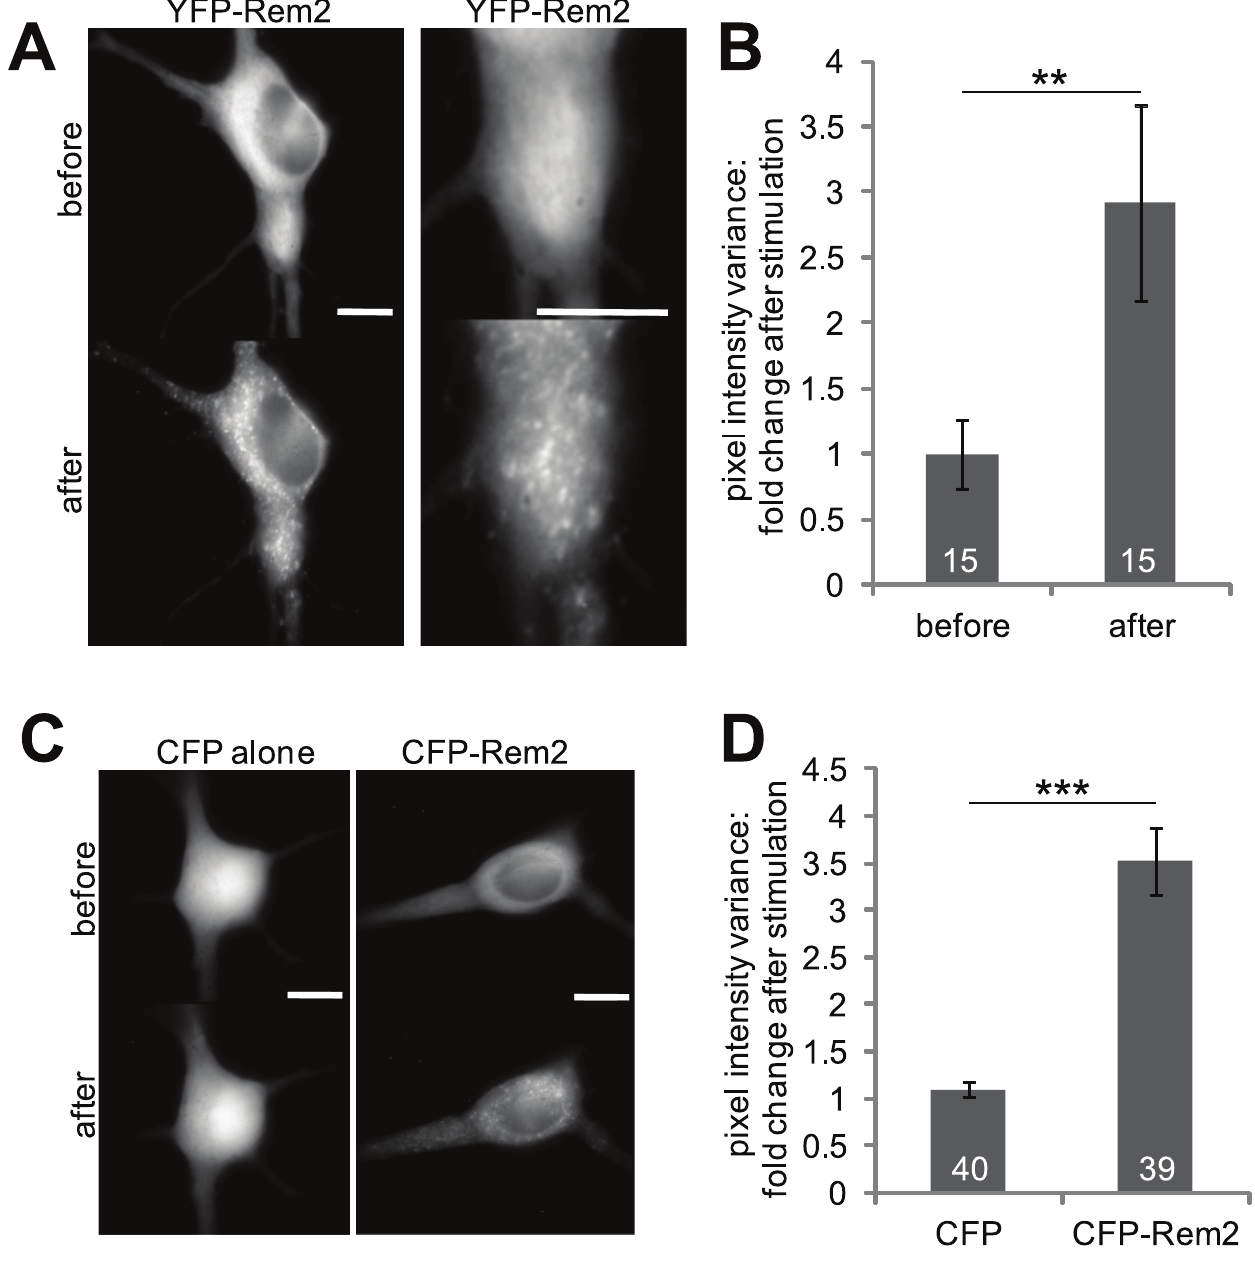
Figure 1. Rem2 overexpressed in neurons redistributes in response to neuronal stimulation. ( A ) Images of neurons expressing either YFP or YFP-Rem2, before and after photoconductive stimulation, a non-invasive method of stimulating individual cells in a culture using light to target neurons grown on a silicon chip. To stimulate specific cells, we targeted the cell bodies of transfected neurons using a YFP filter, then stimulated the chip using 3–5 V of current for 2 msec duration at 20 Hz for 5 sec. Cells were imaged before and after stimulation to compare Rem2 distribution. Right panel is a magnification of the left panel to show details of Rem2 puncta. Scale bars represent 10 m m. ( B ) Normalized pixel value variance before stimulation, 1.0 6 0.26; after stimulation, 2.92 6 0.75, N=15; paired t-test p=0.006. Error bars represent SEM, and numbers within the bars indicate the number of cells averaged. ( C ) Images of neurons expressing either CFP or CFP-Rem2, before and after chemical stimulation. Individual cells in a culture of dissociated hippocampal neurons were imaged and their positions recorded, then the culture was stimulated with bath application of 25–100 m M glutamate/2.5–10 m M glycine. Follow-up images were taken of the recorded cells within 7 minutes of stimulation. Scale bars represent 10 m m. ( D ) Images such as in panel C were filtered and quantified by the variance in pixel values in each image. Variance was normalized to unstimulated cells. Ratio of CFP alone after/before stimulation, 1.10 6 0.07, N=40; ratio of CFP-Rem2, 3.52 6 0.36, N=39; t-test p , 0.001. Numbers within the bars denote numbers of cells averaged for each bar. Error bars are SEM. doi:10.1371/journal.pone.0041185.g001 interaction between full length Rem2 (L317G) and CaM, this interaction between Rem2 and CaM near residue 317 is necessary mutant showed significantly reduced stimulation-induced cluster- for Rem2 redistribution. Finally, Rem2 (1–320) L317G did not ing when expressed in neurons (Figure 4E), suggesting that an form constitutive puncta and did not undergo redistribution after